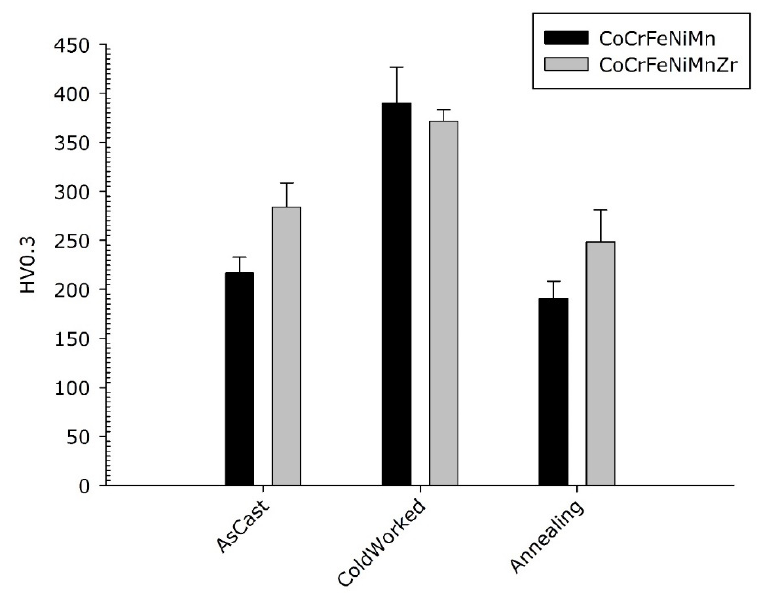
Figure 11. Micro-hardness of Co 20 Cr 20 Ni 20 Fe 20 Mn 20 and Co 19 Cr 19 Ni 19 Fe 19 Mn 19 Zr 5 alloys.